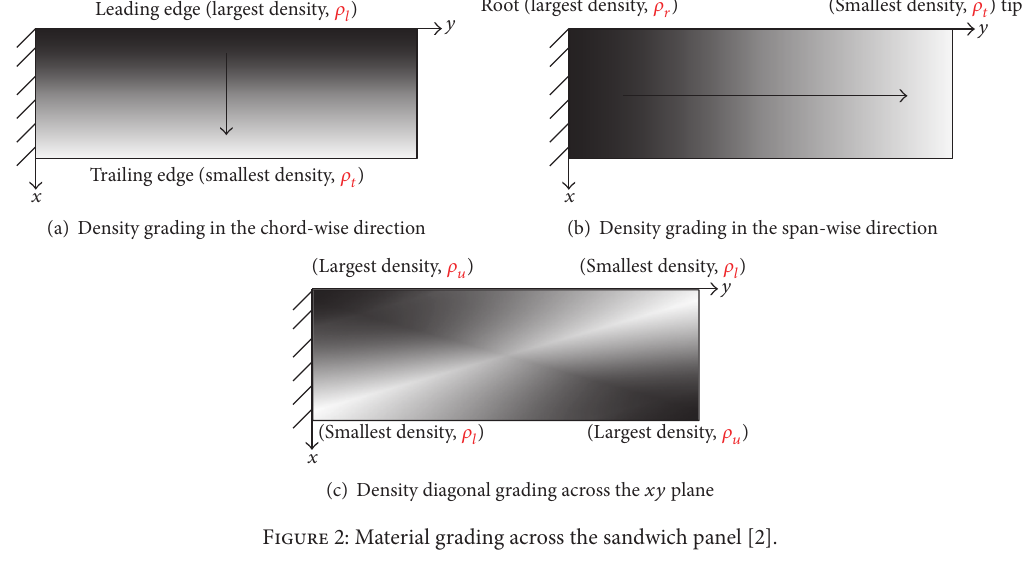
Figure 2: Material grading across the sandwich panel [2].